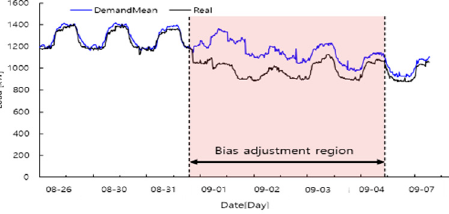
Figure 9. Permanent bias error correction effect.